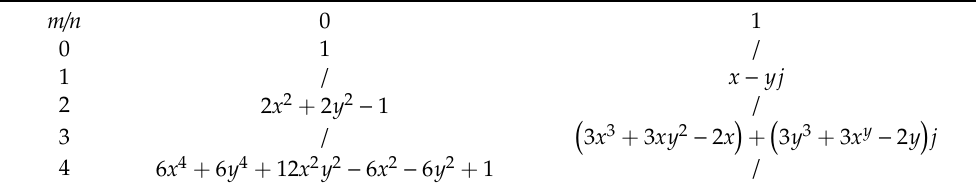
Table 1. Zernike orthogonal complex polynomials ( V n , m )